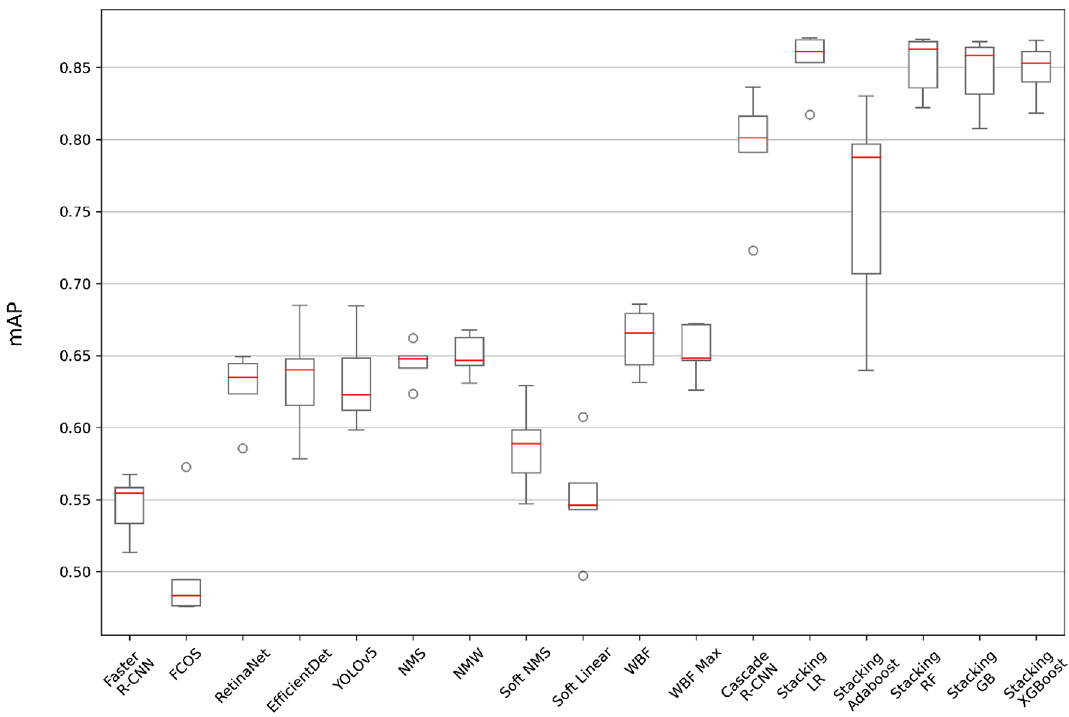
Figure 5. mAP comparison through boxplots. The tested models (base-learner models, ensemble models, Cascade R-CNN and StackBox models) are compared in terms of mAP. The figure shows the distribution of the results on the fivefold